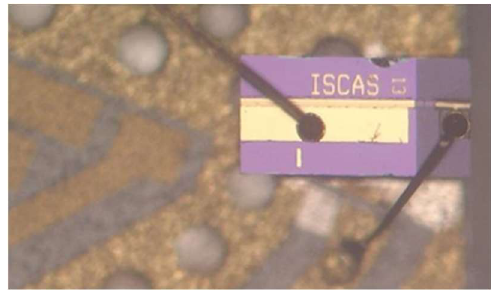
Figure 2. An optical image of an EML laser bound to an AlN submount.